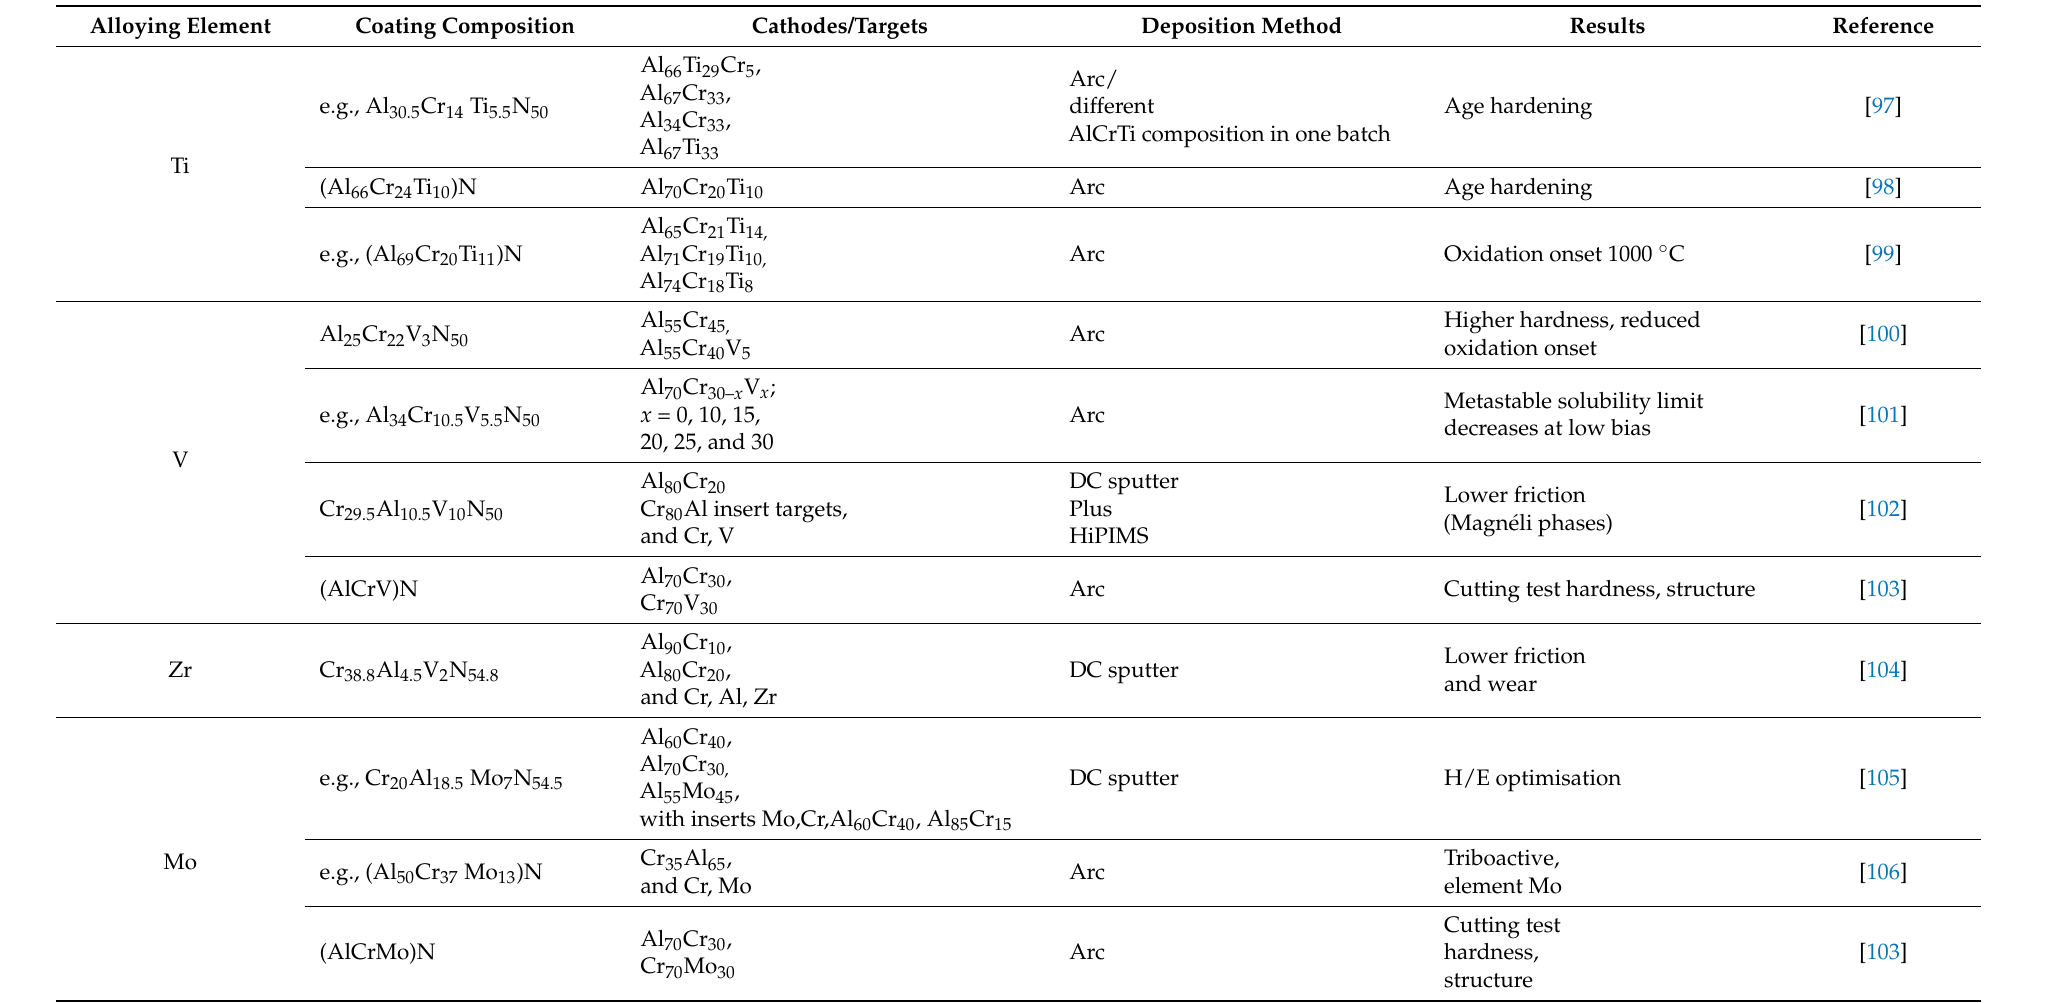
Table 2. Selected coatings alloyed with one metal and metalloid